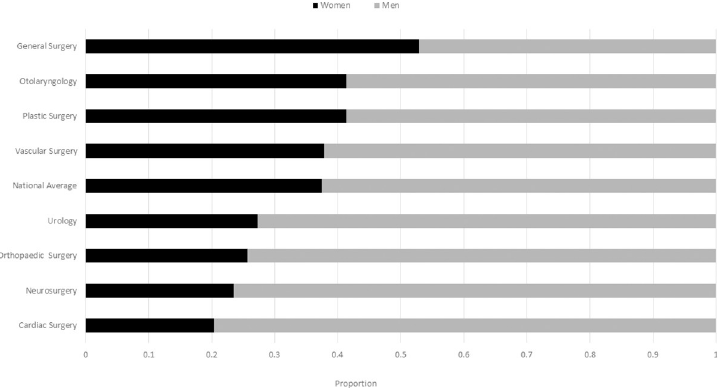
Fig 8. Proportion of women to men surgical residents by specialty. Ordered from highest proportion of women surgeons to lowest proportion. Significant differences exist between specialties (p < 0.00001).